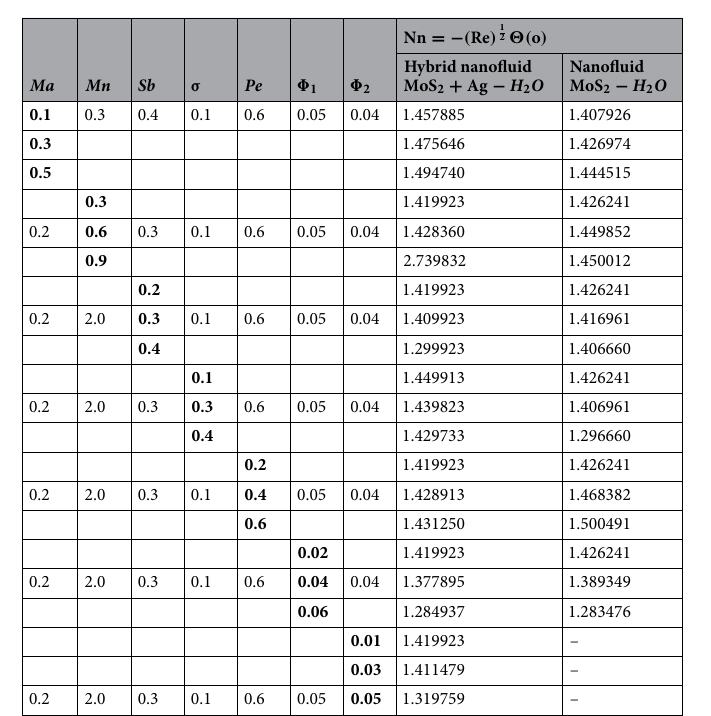
Table 5. Effect of several parameters on local density of motile microorganisms. Significant values are in